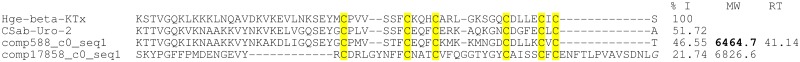
Putative β-KTxs found in U. yaschenkoi transcriptome.Multiple alignments of U. yaschenkoi sequences that code for putative β-KTx. These sequences belong to the long chain scorpion toxin family, Class 2 subfamily. U. yaschenkoi β-KTx sequences are compared against CSab-Uro-2 from U. manicatus and with the Hge-β-KTx from Hadrurus gertschi. All these sequences have 6 cysteines (highlighted in yellow). The percentage of identity (%I) is shown in relation to Hge-β-KTx. The theoretical molecular weight (MW) of U. yaschenkoi toxins is shown. In bold, the MW found in the mass fingerprint previously reported [41]. The retention time (RT) of this component is also indicated. Note: Sequence comp596_c0_seq1 (not shown) codes for the same mature peptide as the sequence comp588_c0_seq1 from this alignment.